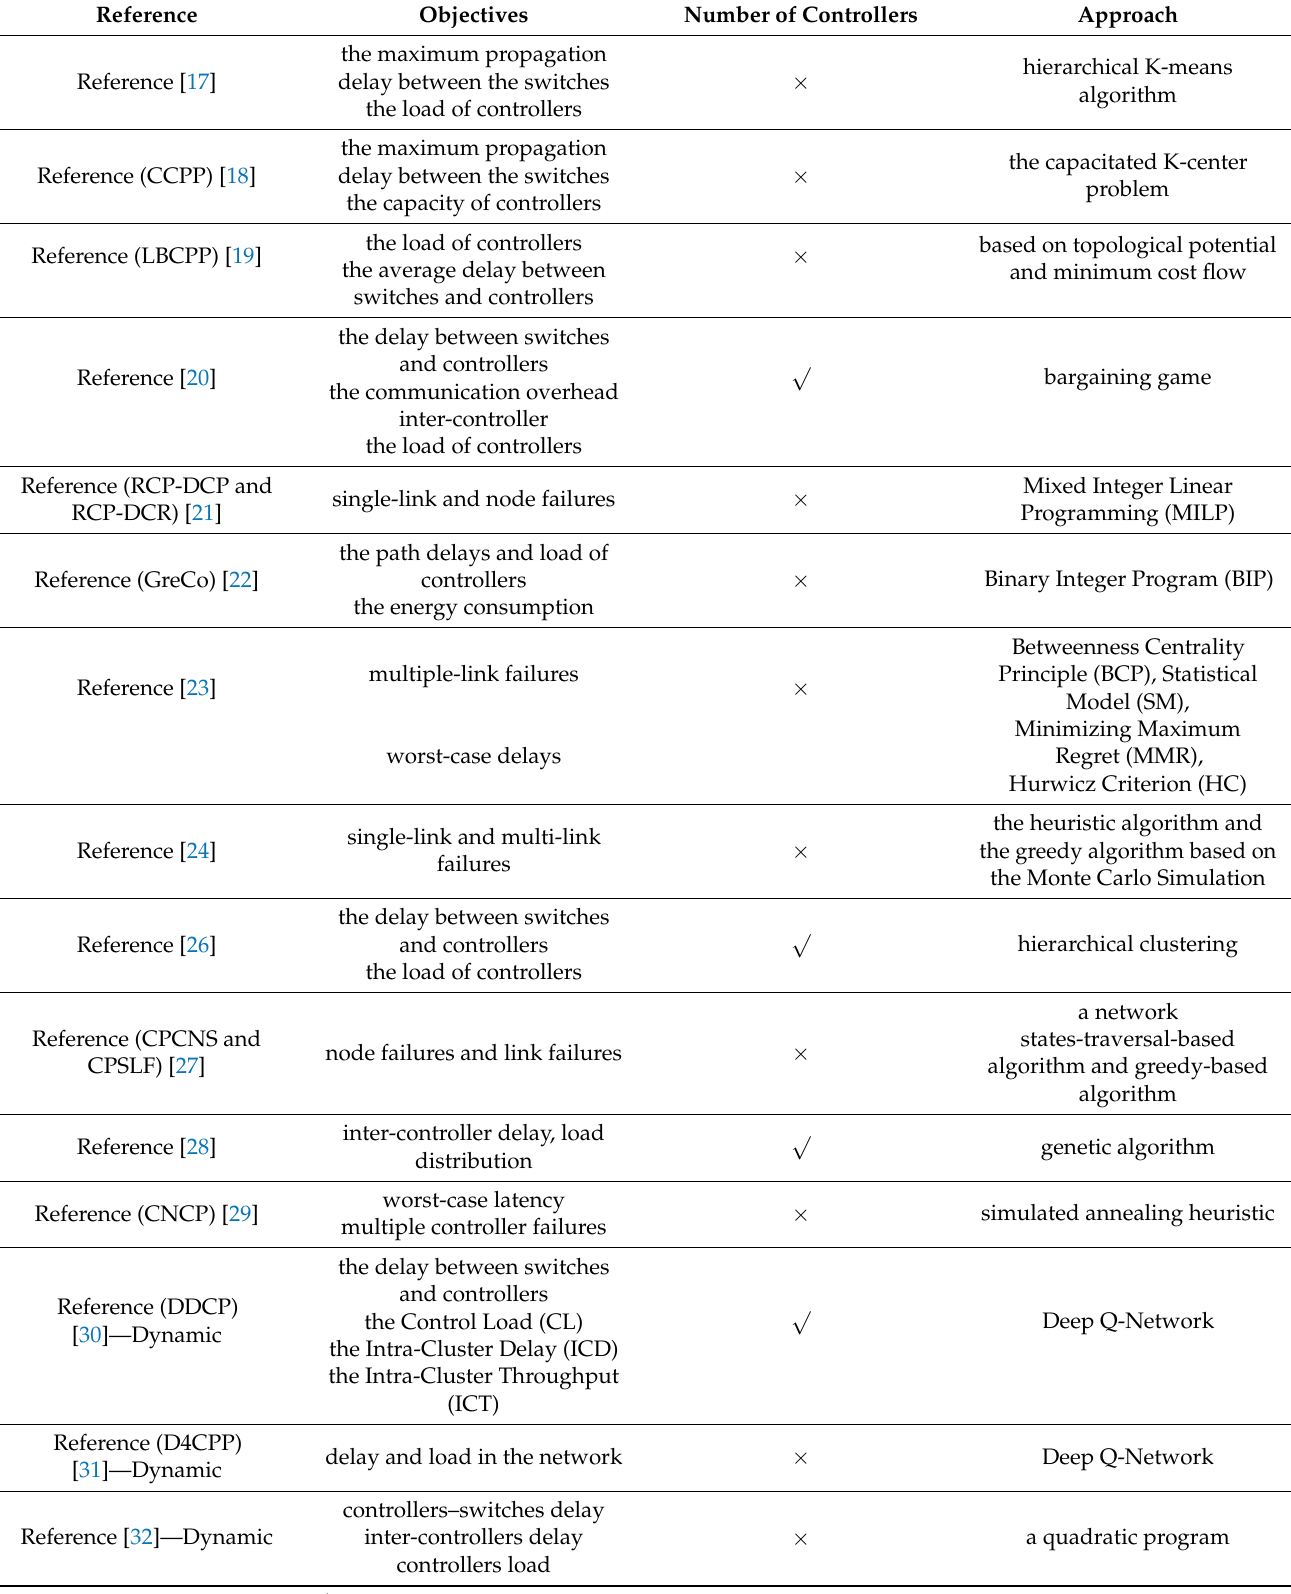
Table 1. Summary of relevant